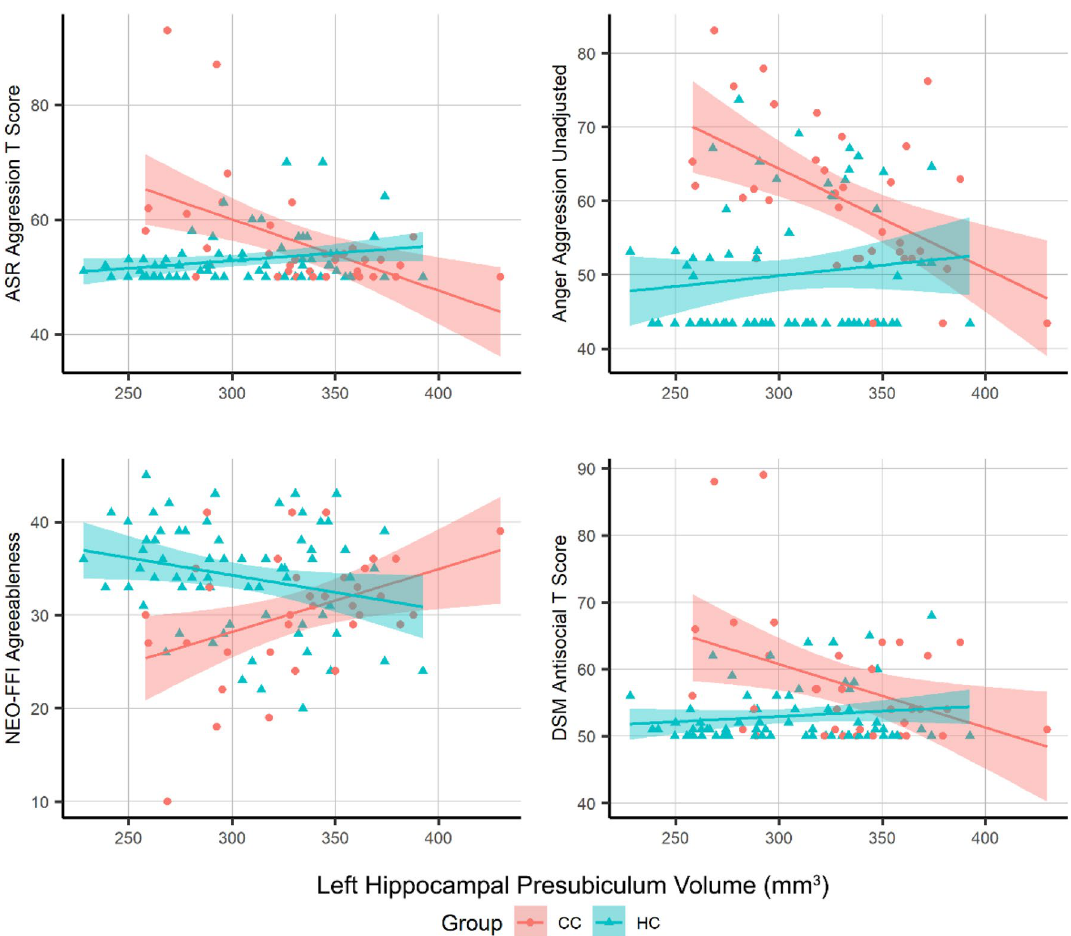
Figure 3. Significant interaction model results that were between left hippocampal presubiculum and four behavioral variables. CC: Childhood history of Conduct, HC: Healthy Controls, ASR: Adult Self